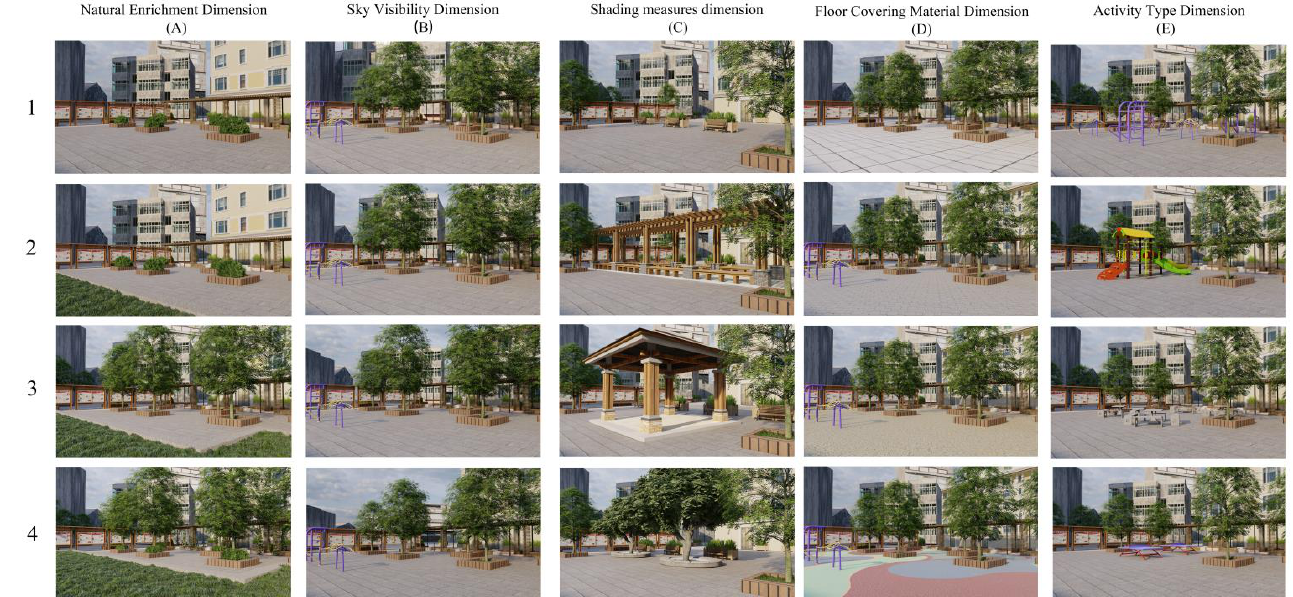
Figure 1. Stimulus material design for different landscape parameter configurations used for the